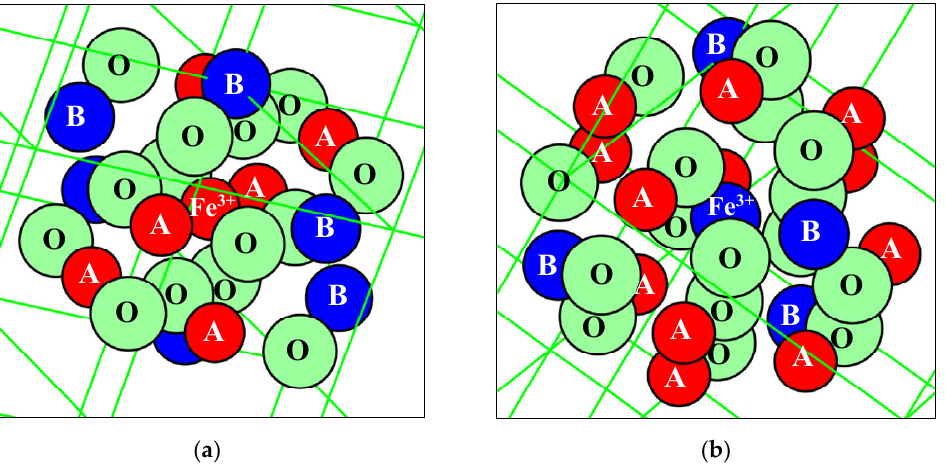
Figure 64. Local microenvironments of Fe 3+ cation in the (A) ( a ) and [B] ( b ) sites of the ideal CuFe 2 O 4 crystal: O (green circles) are O 2– ions, A (red circles) are tetrahedral sites occupied by Fe 3+ cations, and B (blue circles) are octahedral sites occupied by both Fe 3+ and Cu 2+